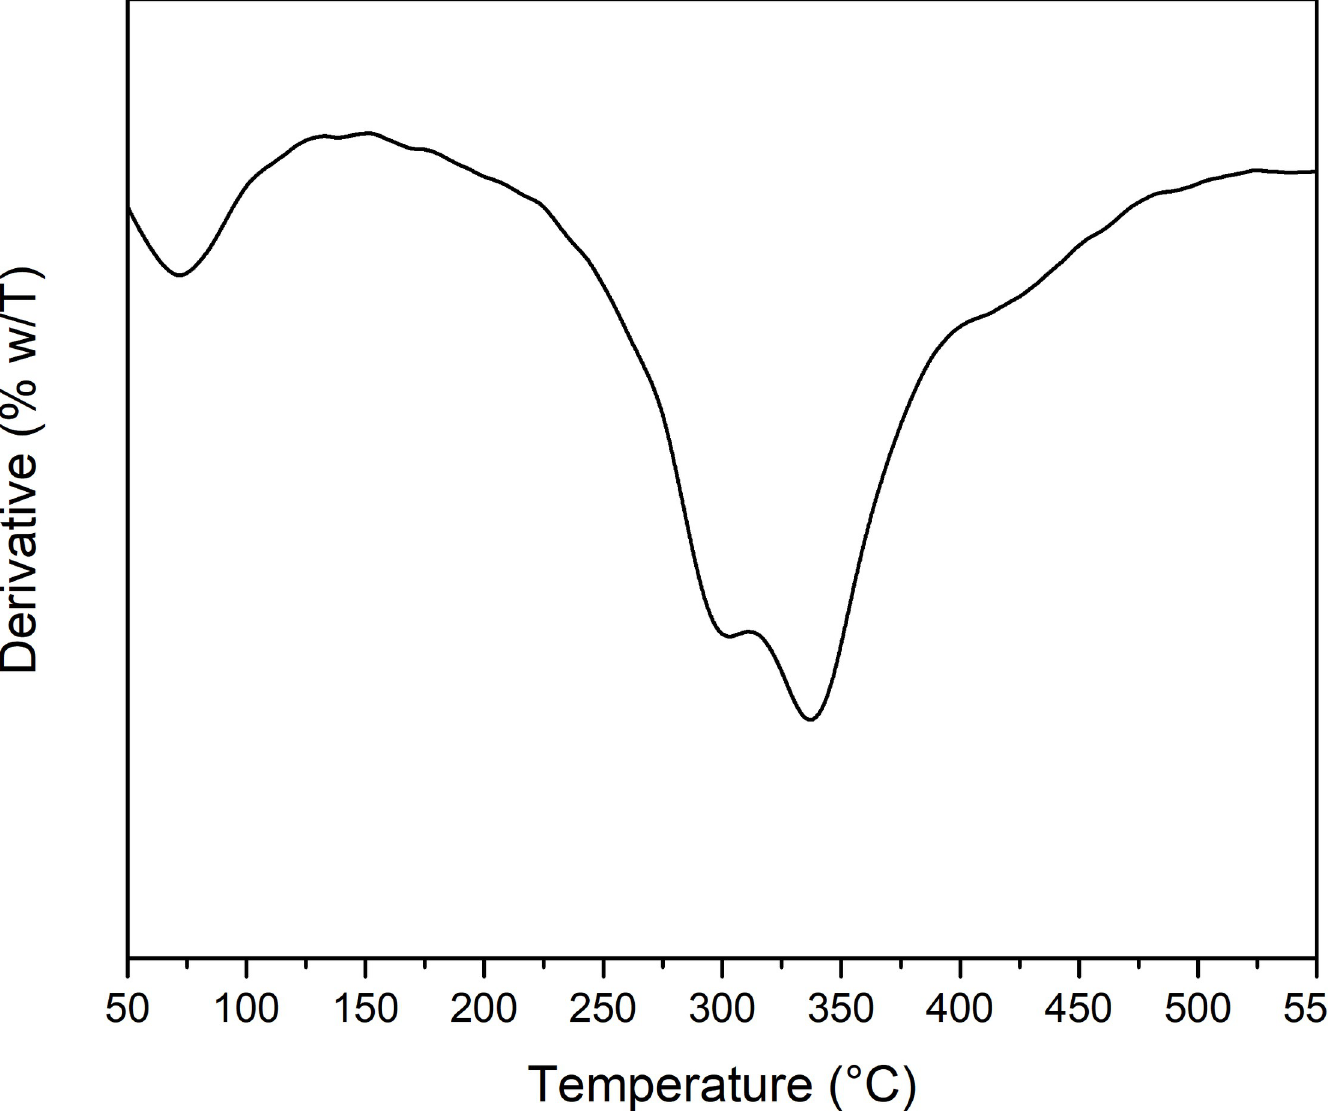
Fig 1. DTG thermogram of